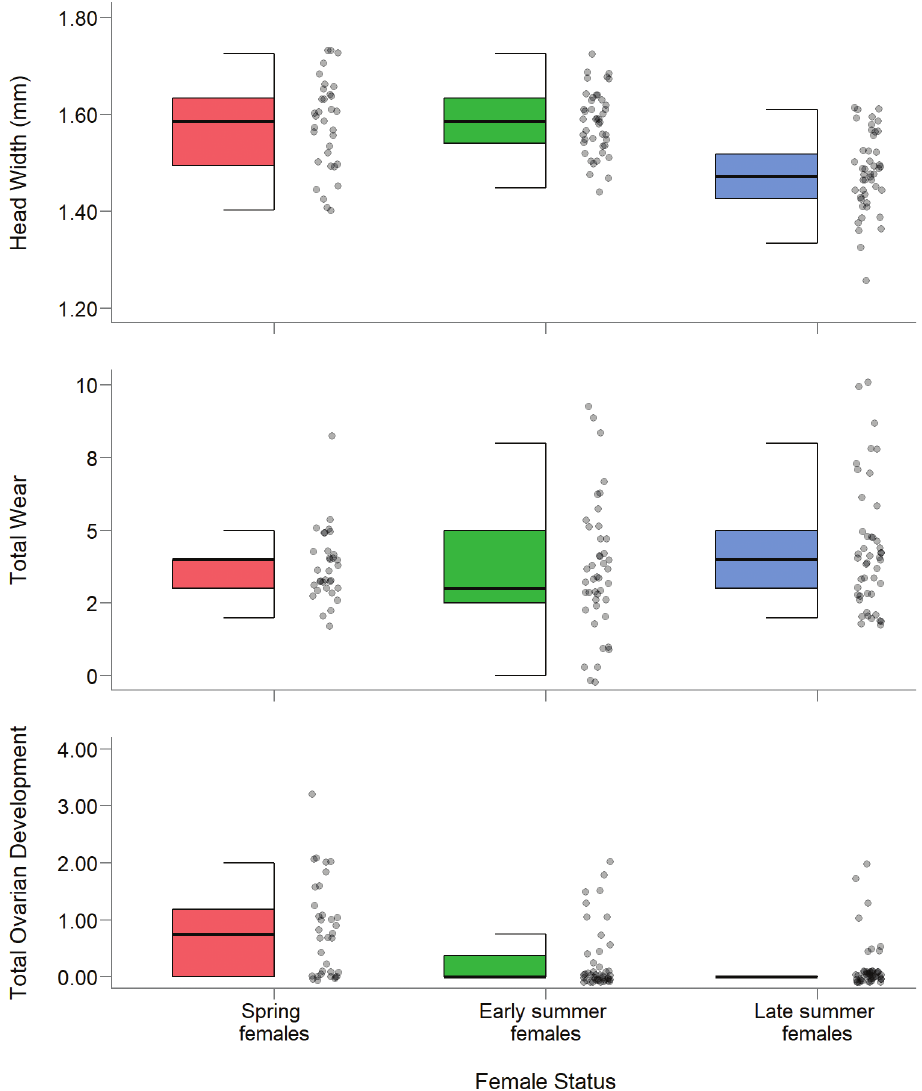
Figure 3. Social trait comparisons among spring, early summer and late summer females of L. hitchensi . Spring females were caught in weeks 0 to 8, early summer females in weeks 10 to 15, and late summer females from week 16 onward. Early summer females were larger than late summer females but showed similar signs of wear and ovarian development. See Table 2 for statistical